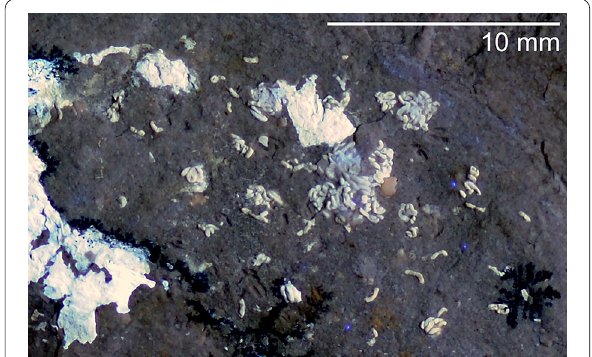
Fig. 5 Questionable renal concrements of Syrionautilus libanoticus ; PIMUZ 37706, Cenomanian, Hadjoula, Lebanon. Detail of Fig.